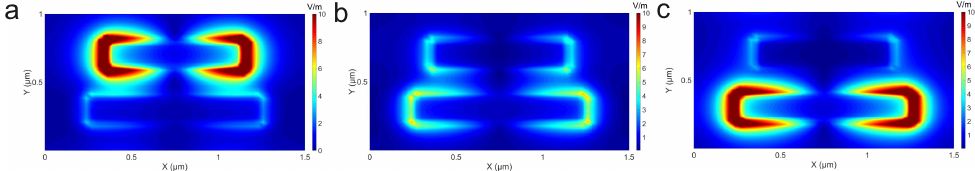
Figure 4. E-field magnitudes at 0.5 eV: ( a ) E-field magnitude at 3.49 µ m. ( b ) E-field magnitude at 3.80 µ m. ( c ) E-field magnitude at 4.22 µ